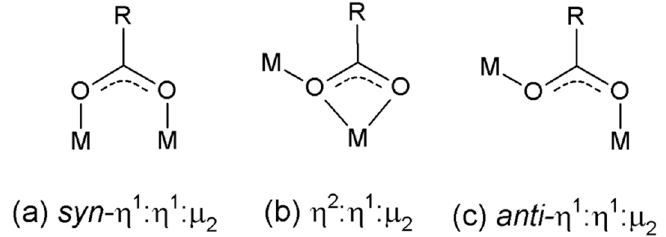
Figure 1. Selected coordination motifs for carboxylate-containing ligands.